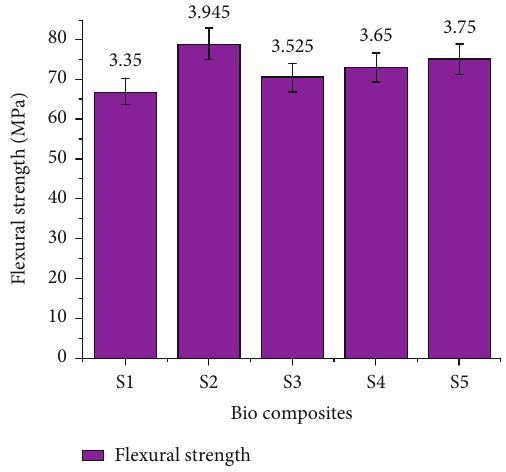
Figure 2: Variations of fl exural strength with KF/JF fi ber biocomposites.